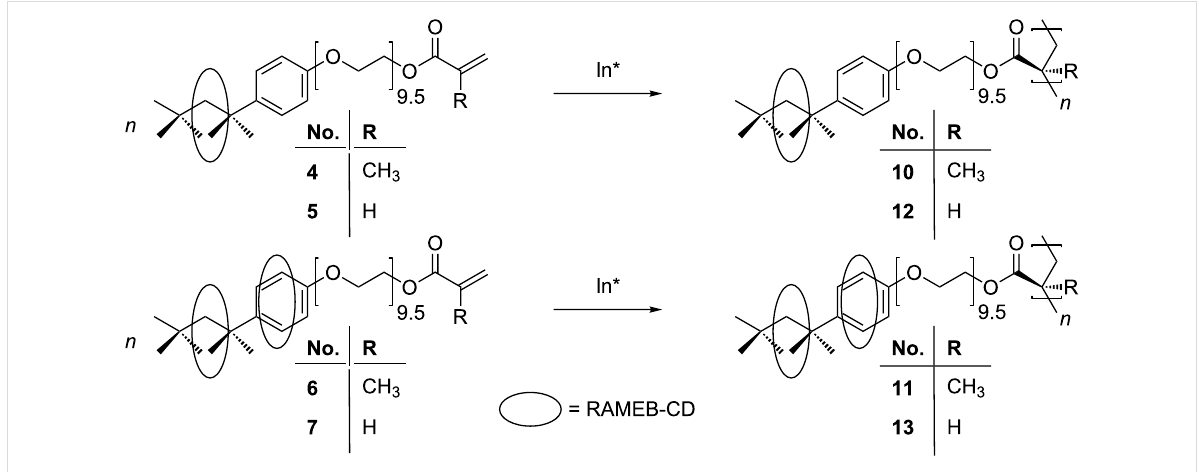
Scheme 3: Polymerization of the RAMEB-CD complexed monomers 4 , 5 , 6 and 7 to the homopolymers 10 , 11 , 12 and 13 in water with VA-044 as initiator.